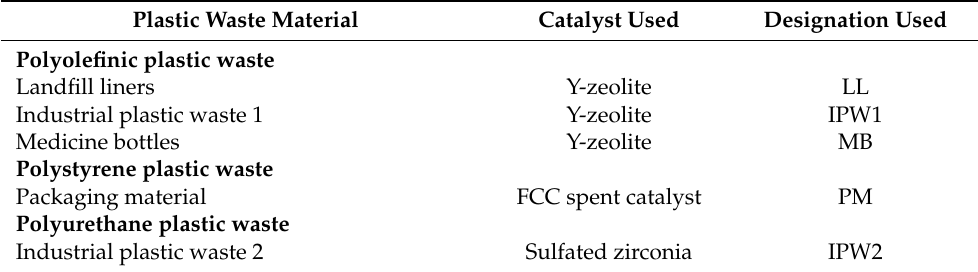
Table 1. Description of plastic waste materials and catalyst used for the Py-GC/MS